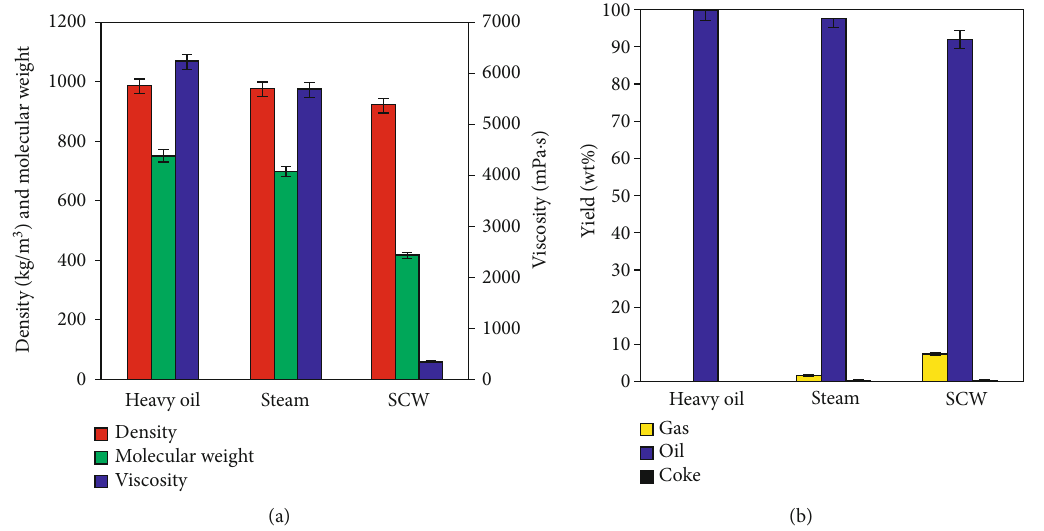
Figure 2: Experimental results of pyrolysis: (a) oil properties and (b) product distribution.